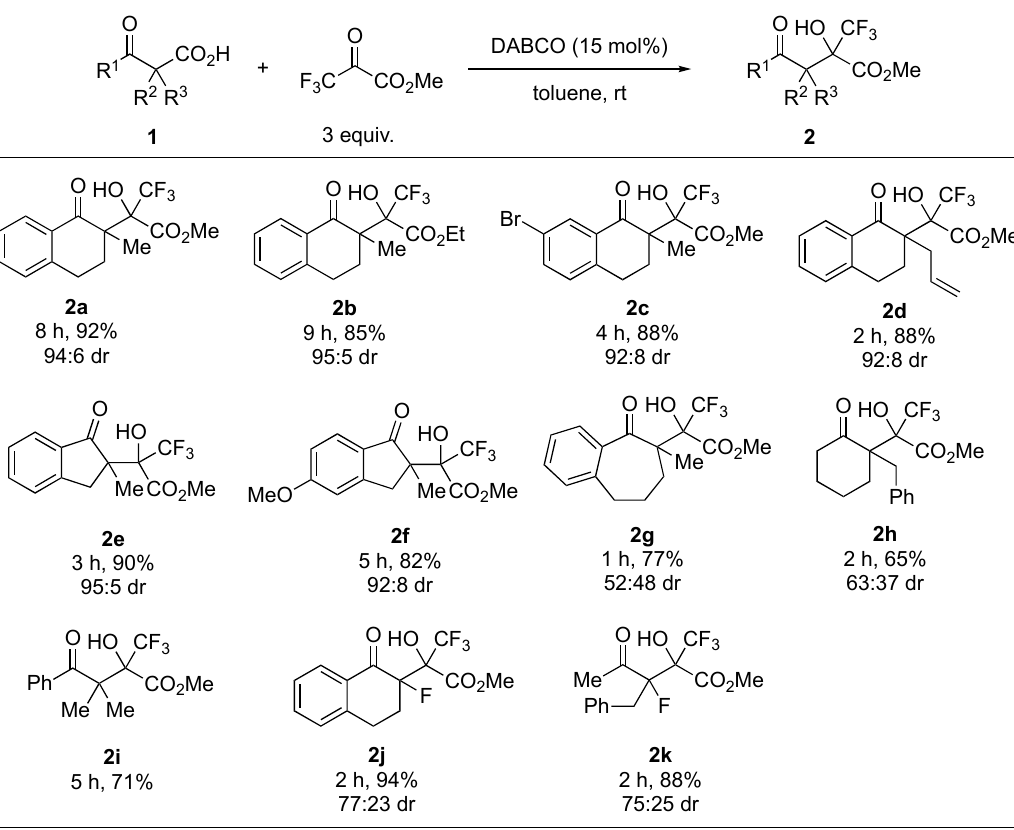
Figure 2. Substrate scope 1 . 1 All reactions were carried out at room temperature in toluene with 3 equiv. of trifluoropyruvates in the presence of 15 mol% DABCO. Isolated yields were described. Diastereomeric ratios were determined by 1 H-NMR